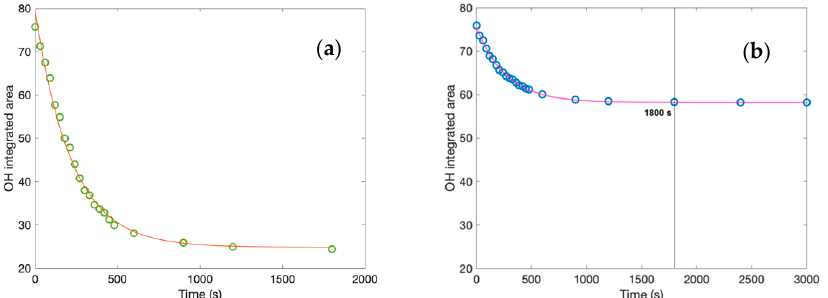
Figure 5. Integrated area values of the OH-stretching region, i.e., 2800–3700 cm − 1 , for all the investigated spectra as a function of time in the spectral range 2800–3700 cm − 1 for: ( a ) creatine aqueous solution; ( b ) creatine aqueous solution in the presence of trehalose.